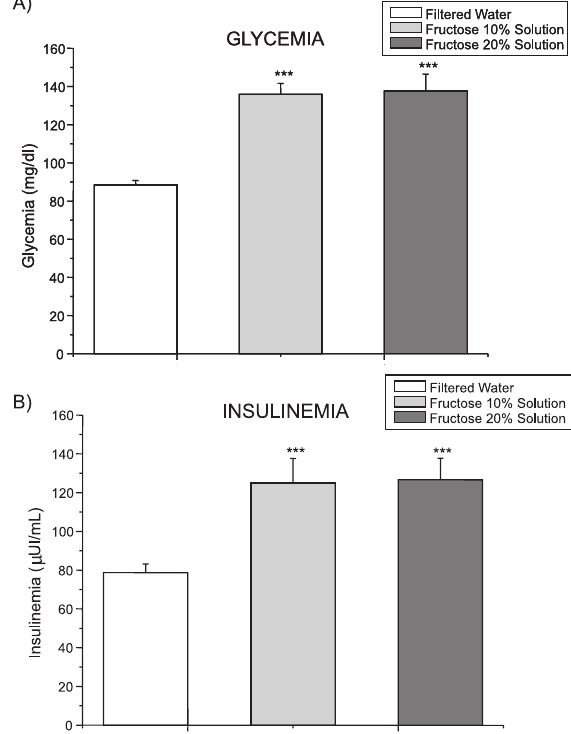
Figure 3 - Effects on glycemia (a) and insulinemia (b) of filtered water, 10% fructose solution, or 20% fructose solution on animals treated for 6 months.. Results expressed as mean ± SEM; *** = P < .001 compared to